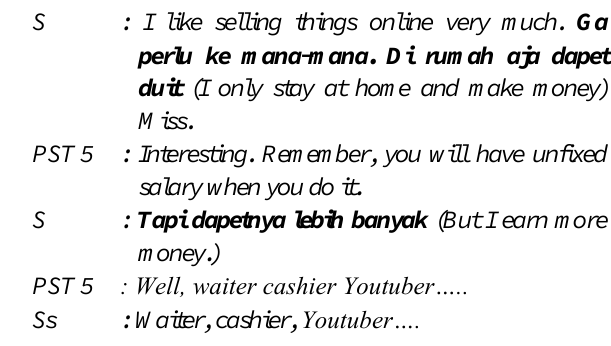
Figure 11 elucidates that non paper-pencil evaluation worked very well with YLs. Playdough solar panel, windmill, and micro hydro power plan were made and presented by the students to their classmates by using the vocabulary that they had learned during the session.